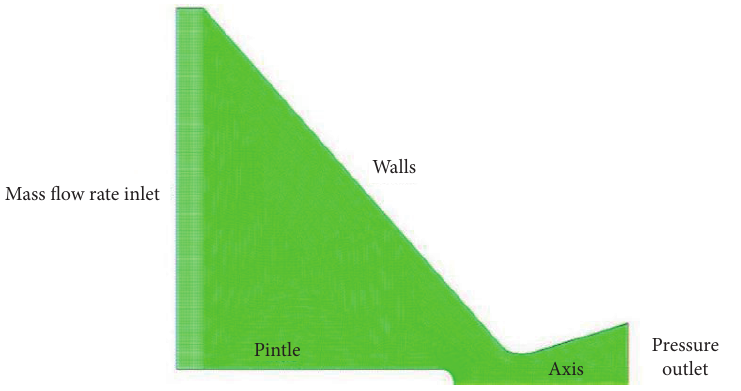
Figure 4. Applied boundary conditions.